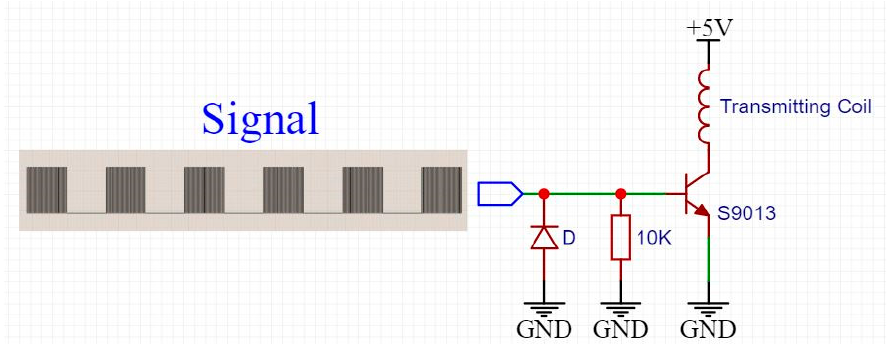
Figure 8. Test signal and transmitting circuit.